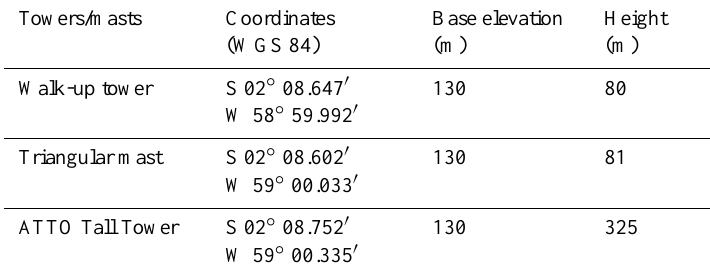
Table 1. Location and specifications of the towers and masts at the ATTO site.